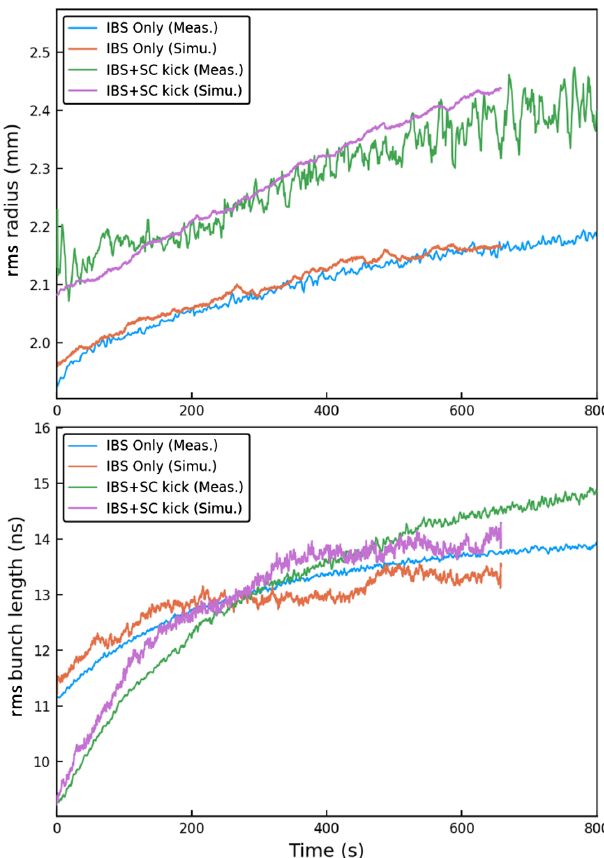
FIG. 7. Measurementandsimulationresultsfortheheatingeffect of the ion beam caused by IBS and the SC from the electron beam.